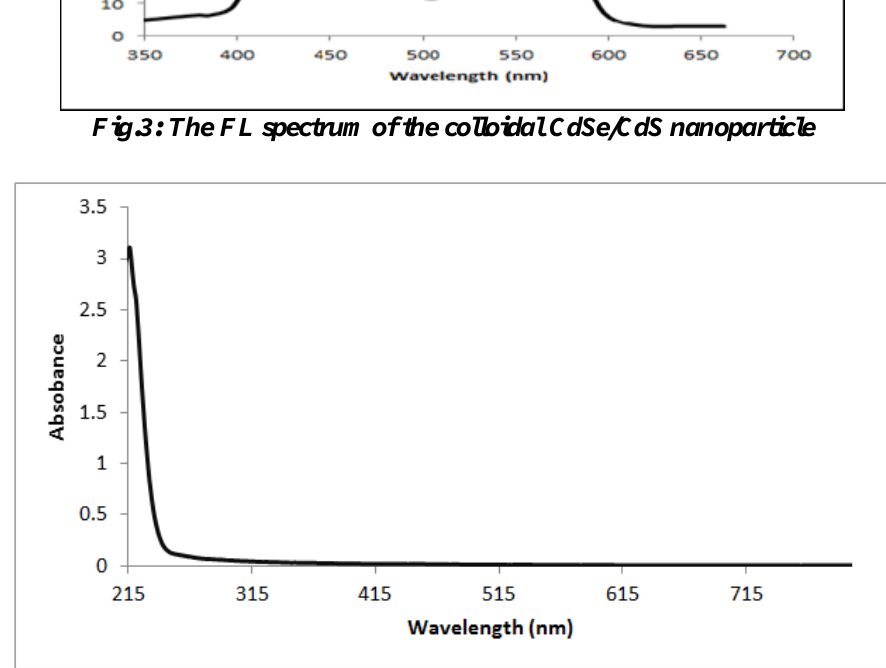
Fig.4: Absorption spectrum of polyacrylamide polymer